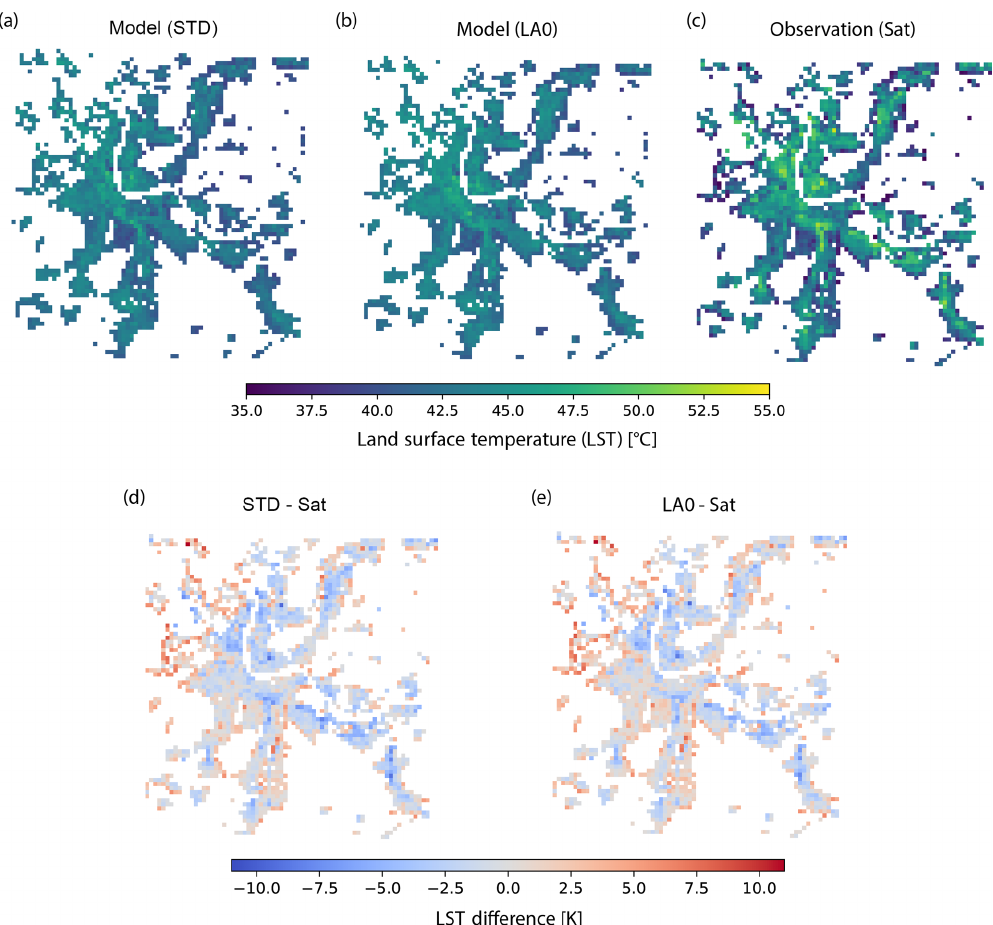
Figure 8. Spatial distribution of LST ( ◦ C) on 5 July 2015 at approximately 11:10 local time (LT) (10:10UTC). Panels (a, b) show the simulated LST with the STD and LA0 configurations, respectively; panel (c) shows the observed LST from the Landsat 7 satellite; panels (d, e) show the LST differences between simulated and observed LST for the STD and LA0 configurations, respectively. Grid cells contaminated by the presence of the river or clouds have been removed.